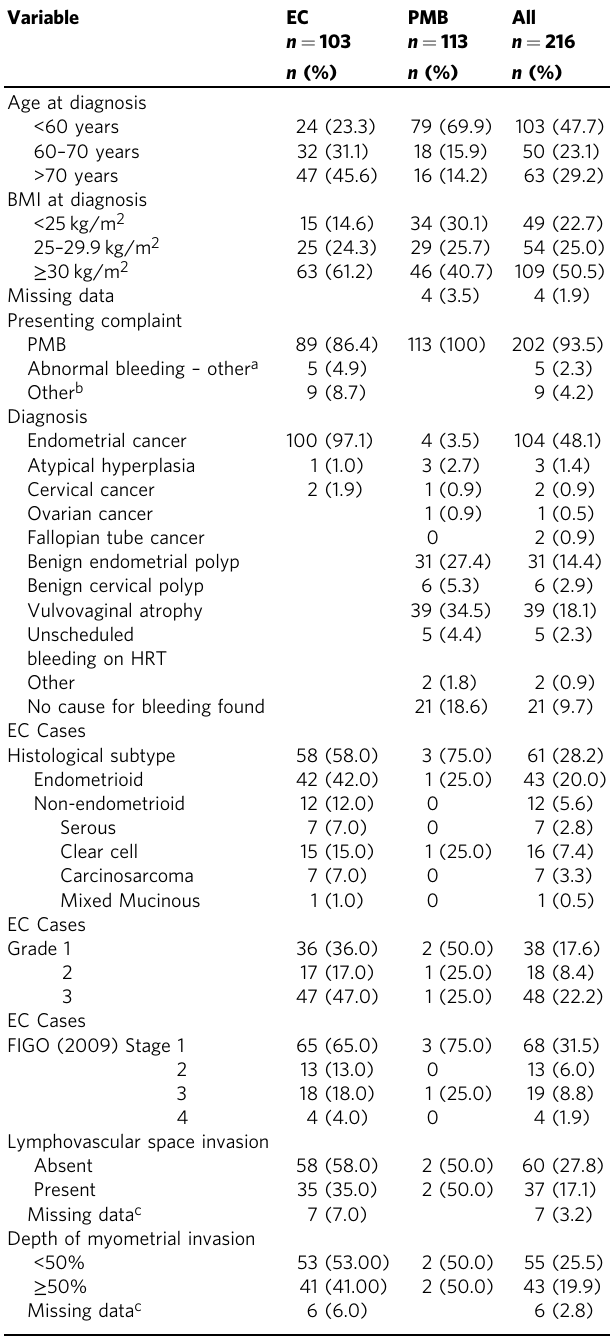
Table 1 Baseline characteristics of study